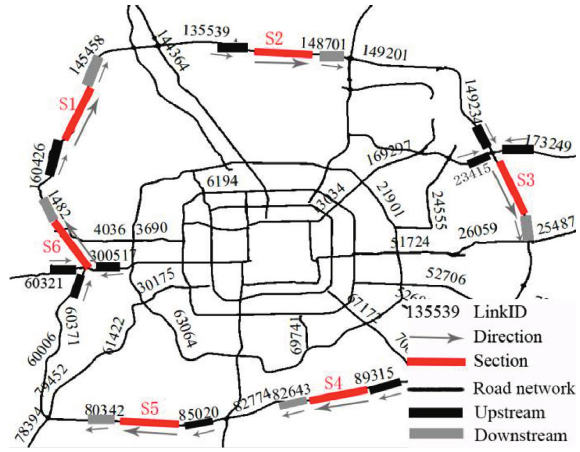
Figure 4: Truck traffic flow